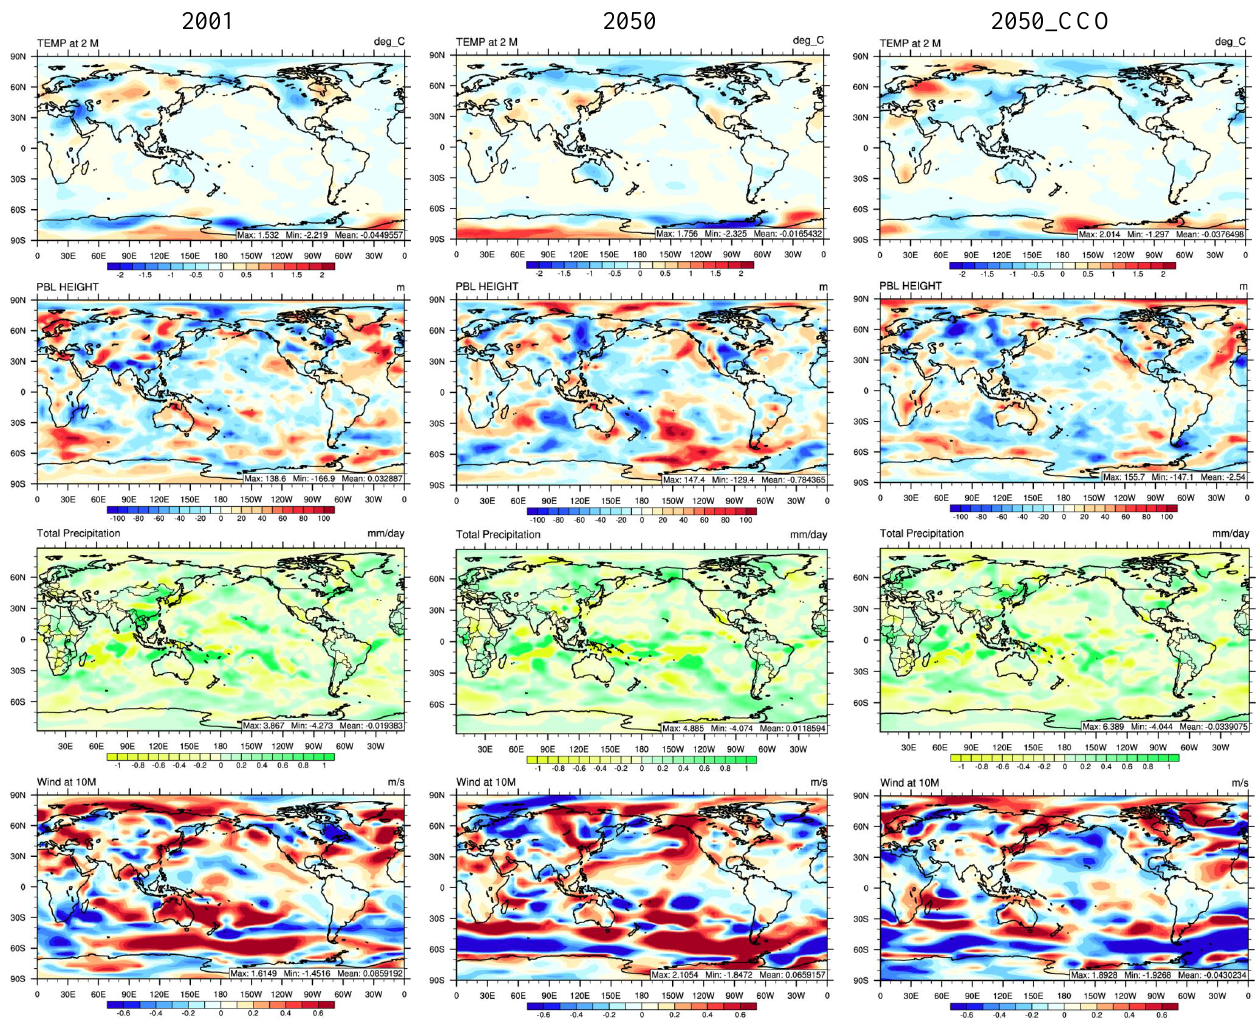
Figure 10. The difference in the spring (MAM) average 2 m temperature, planetary boundary layer height, total precipitation rate, and 10 m wind speed between the simulations with and without EAAEs for current (2001), future (2050), and climate change only (2050_CCO). PM 2 . 5 level at the surface by ∼ 1–3 µg m − 3 (see Figs. 7